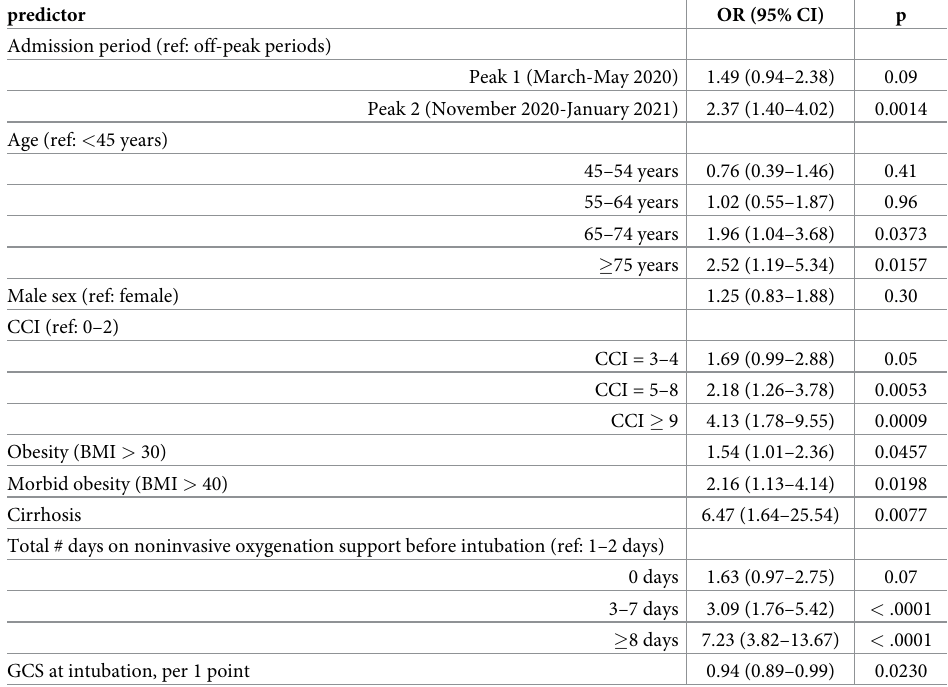
Table 2. Independent predictors of inpatient mortality in COVID-19 patients on mechanical ventilation. predictor OR (95% CI)